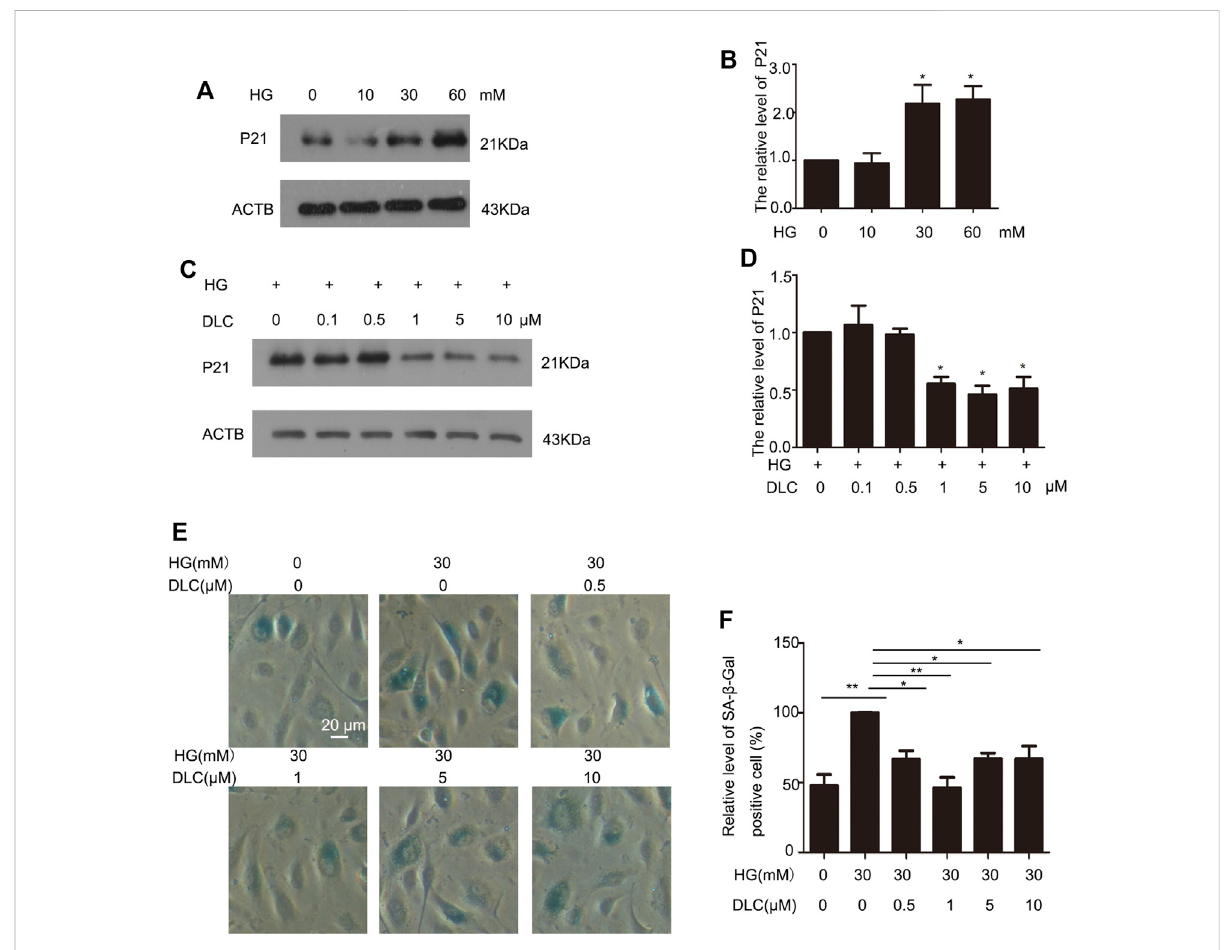
FIGURE 2 DLC inhibited HG-induced senescence of HUVECs. (A,B) . HUVECs were treated with HG (0, 10, 30, 60 mM) for 24 h and protein levels of p21 were determined by western blot. (C,D) . HUVECs were treated with DLC (0, 0.5, 1, 5, 10 μ M) for 24 h under HG (30 mM) condition and protein levels of p21 were determined by Western blot. (E,F) . HUVECs were treated with DLC (0,0.5,1,5,10 μ M) for 24 h under HG (30 mM) condition, cells were detected SA- β -Gal staining. * p < 0.05, ** p < 0.01, n =